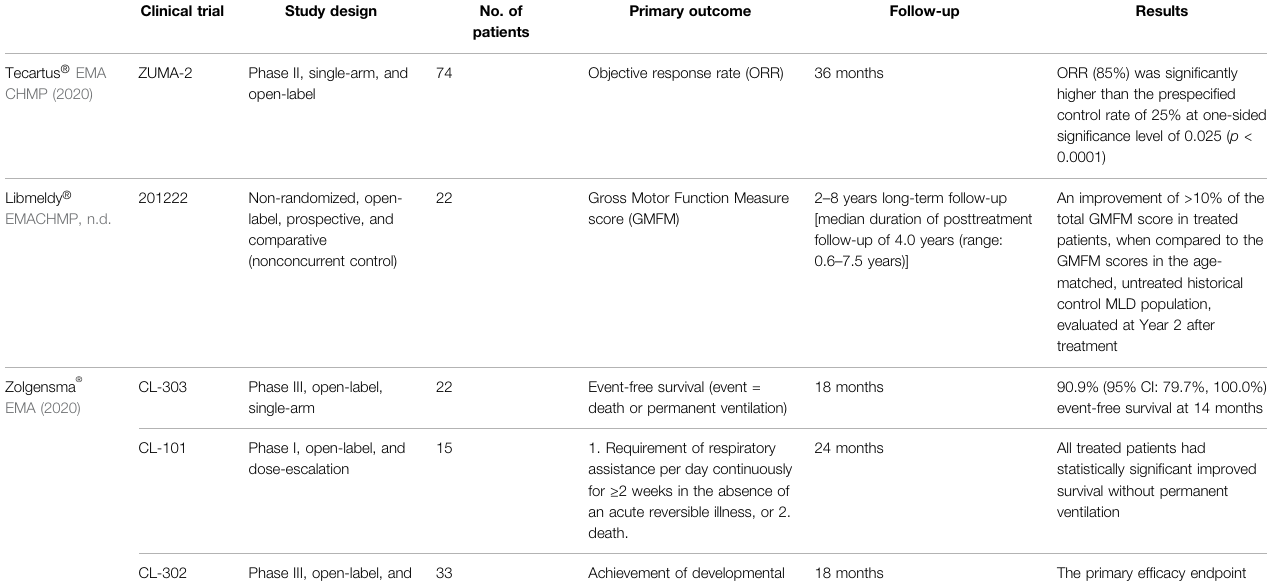
TABLE 2 | Data from clinical trials for ATMPs approved in